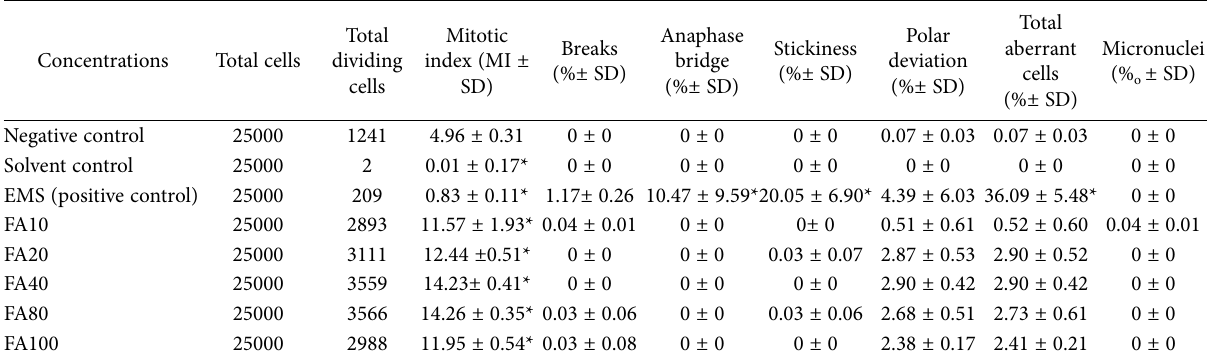
Table 2. Mitotic index values, percentage of chromosomal aberrations and thousandths of micronuclei in control and treatment groups after 24h treatment.